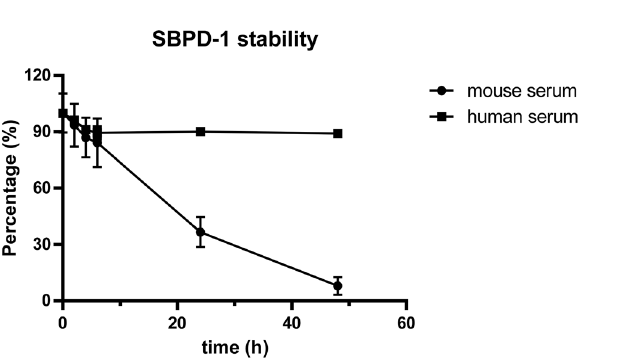
Figure 2. SBPD-1 selectively kills PSMA-expressing cancer cells. Sigmoidal curves of MMAE ( a ), SBPD-1 ( b ), and SBPD-2 ( c ) for cytotoxic activity against PSMA + PC3 PIP and PSMA − PC3 flu cell lines. Results were obtained at 48 h.